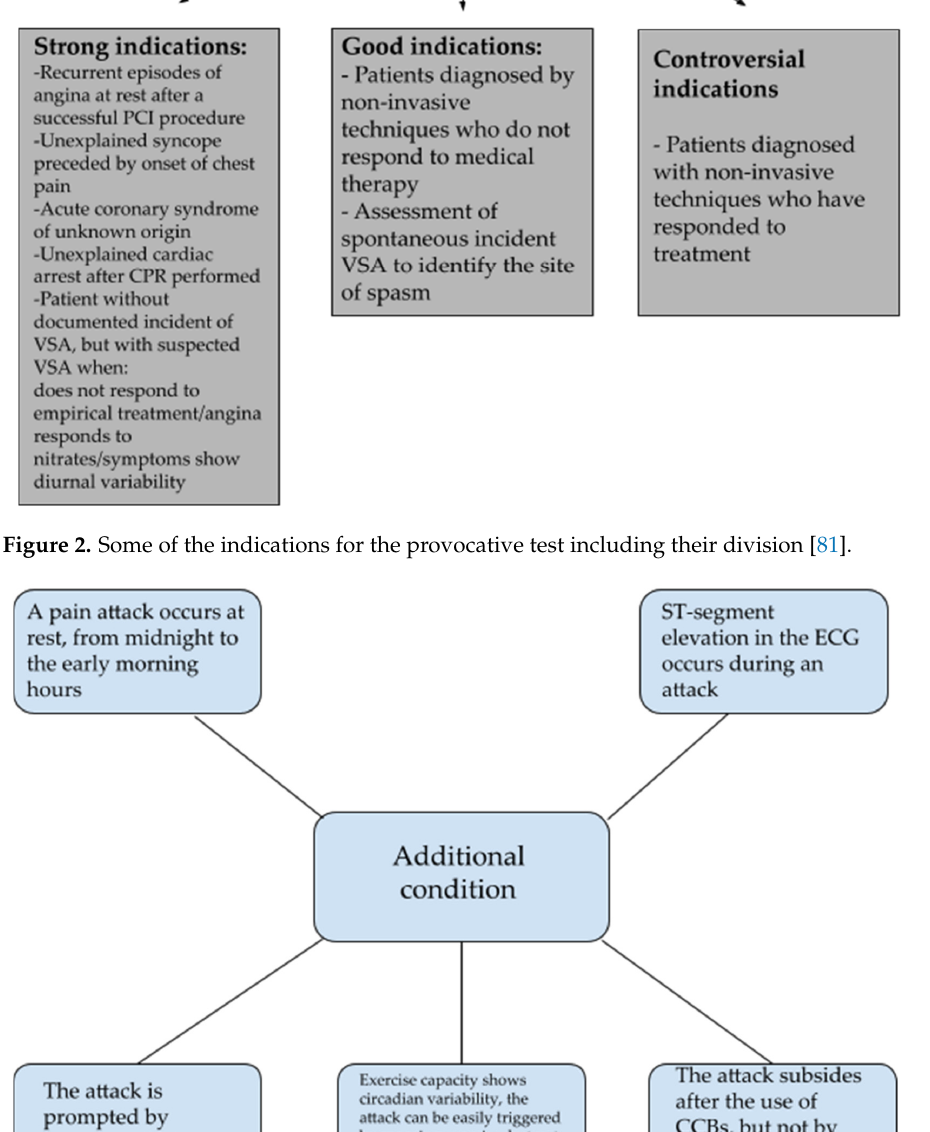
Figure 3. Additional criteria necessary for the diagnosis of angina pectoris when symptoms are re- lieved by nitroglycerin. Meeting one of the listed criteria is sufficient [5]. ECG, electrocardiography; CCBs, calcium channel